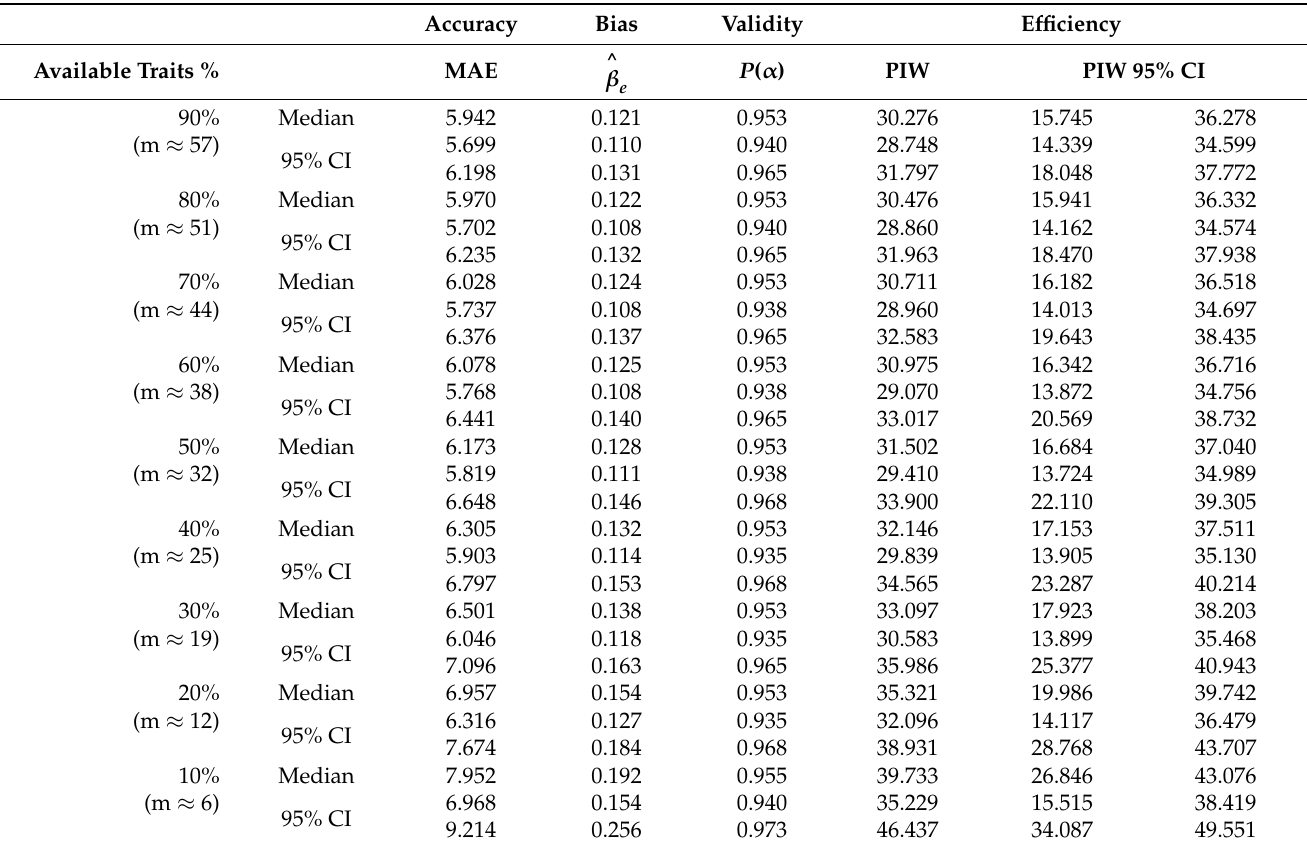
Table 5. Leave-one-out cross-validation metrics for DRNN models built on different fractions of available skeletal